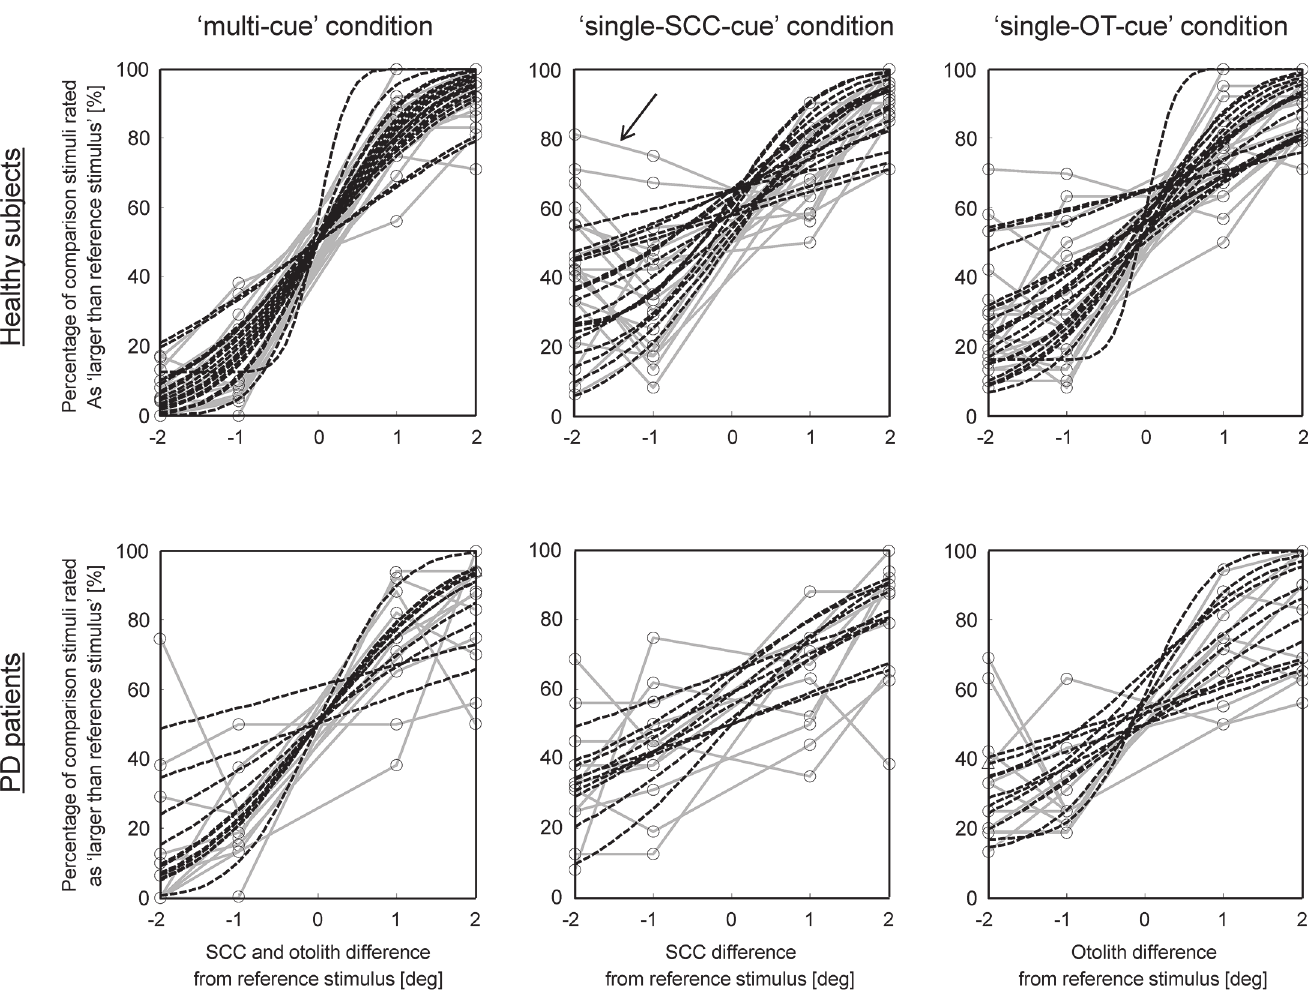
Fig 3. Discrete approximation of the psychometric curves (dots connected by gray lines) and cumulative Gaussian fit of the data representing the psychometric curves (dashed curves) in all healthy subjects (upper panel) and PD patients (lower panel). Abscissa and ordinate as in Fig 2. Arrow: indicates the increased uncertainty during the backward translational — tilt movement compared to the forward translational — tilt movement, although the difference of vestibular activation between the comparison and reference stimulus was equal (see text for further explanation).